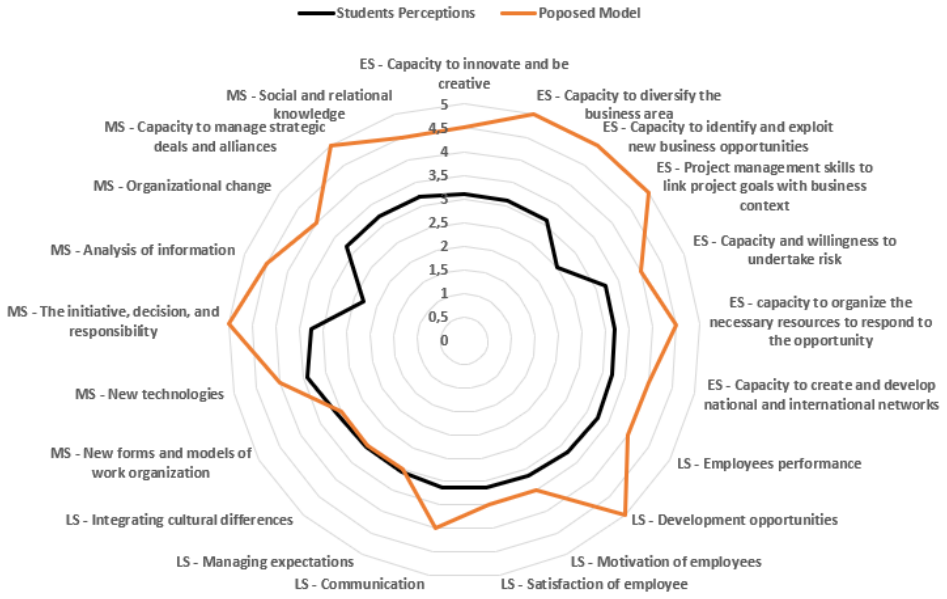
Figure 3. Comparison between Students Perceptions and Model Proposal for Entrepreneur Skills Development.